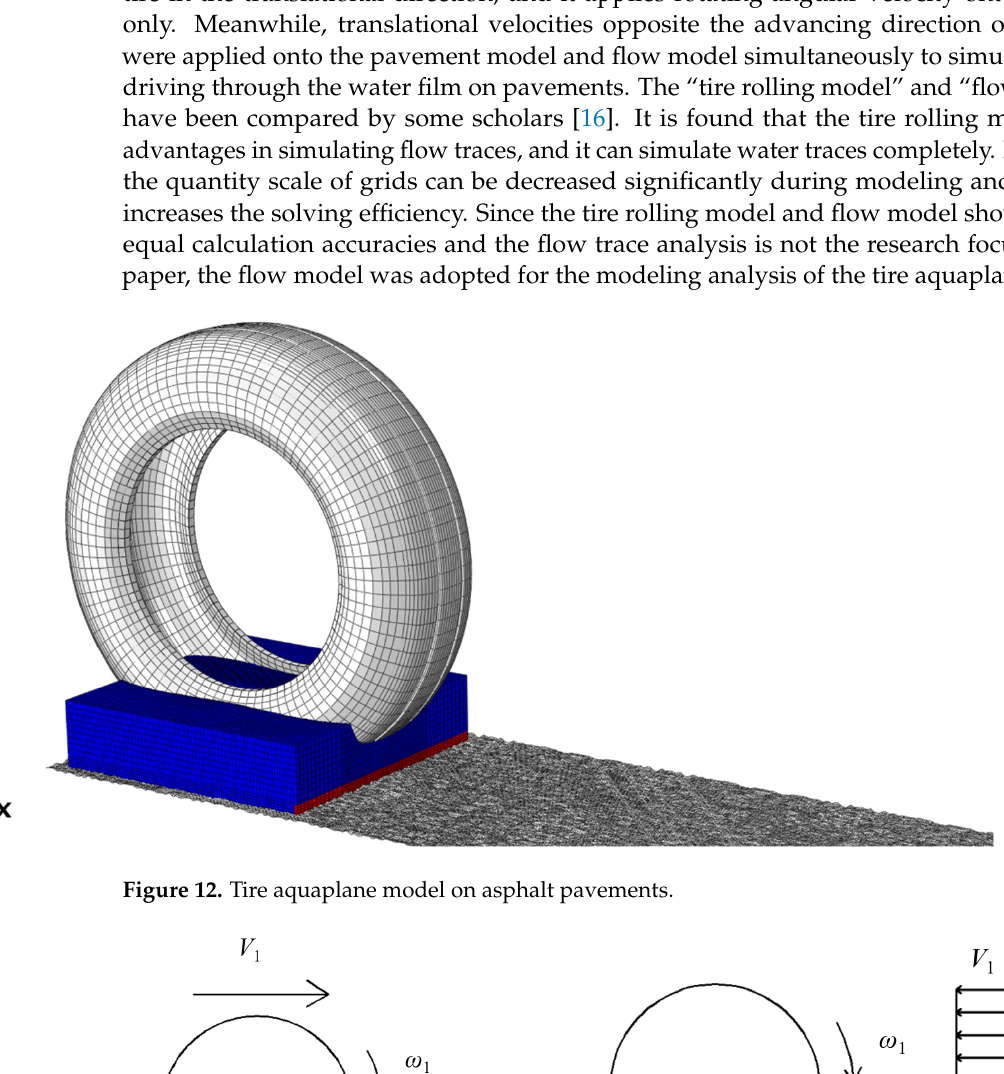
Figure 13. Schematic diagram of different modeling techniques. ( a ) Tire rolling model; ( b ) flow model.